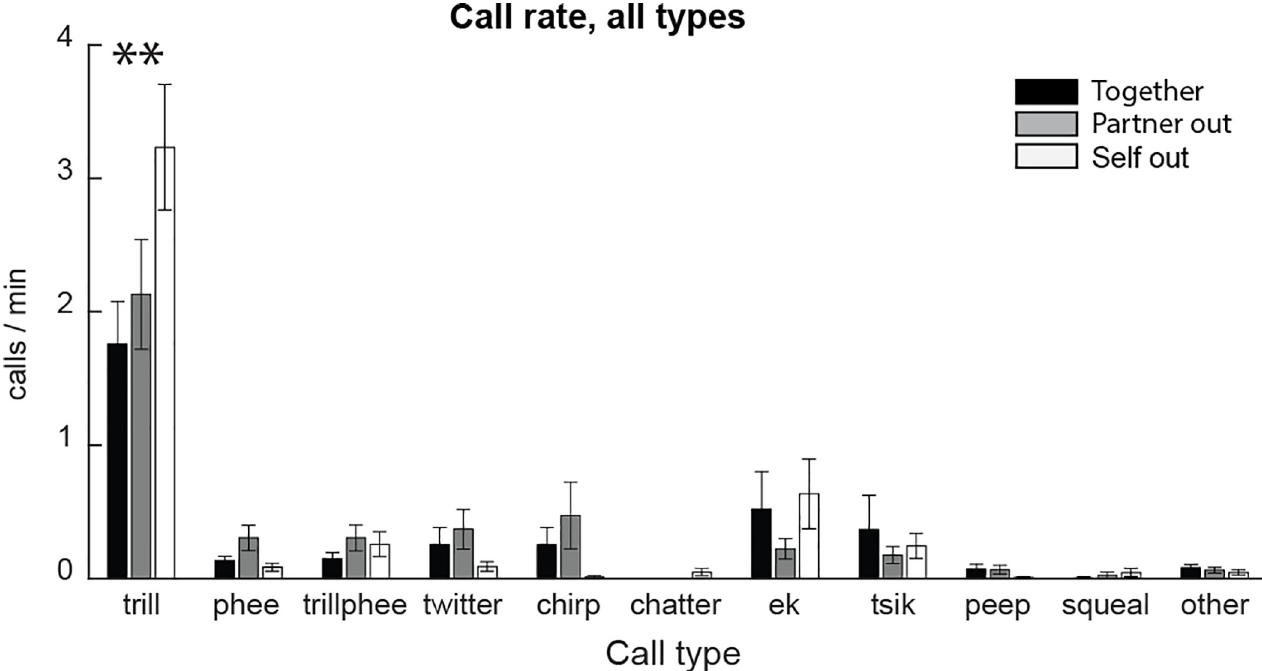
Fig 3. Vocalization rate per animal. Plotted for different call types when animals are together in the home cage (black) or separated, i.e. when the partner is out (gray) or when they themselves are out (white). Trill calls were the most common call type. The rate of trill was higher during separation than when animals were